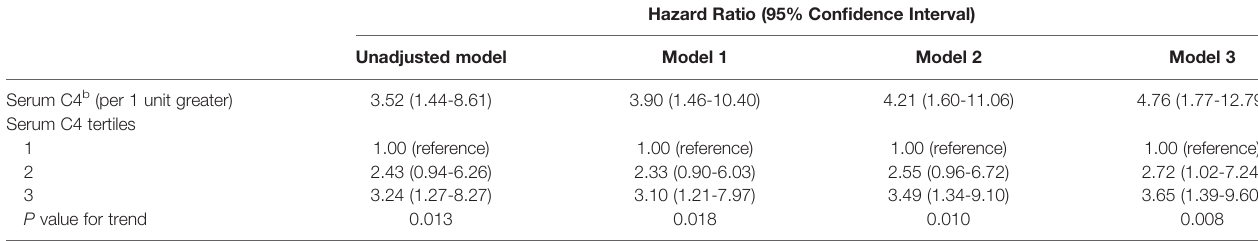
TABLE 4 | Cox proportional hazards ratio model of a renal function progression event a .